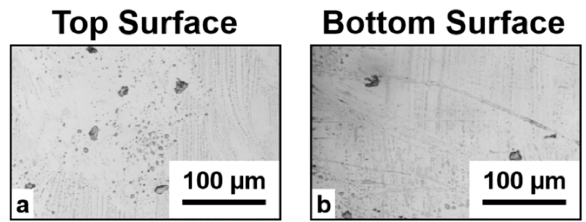
Figure 5. Top ( a ) and bottom ( b ) surface of the target before laser irradiation.